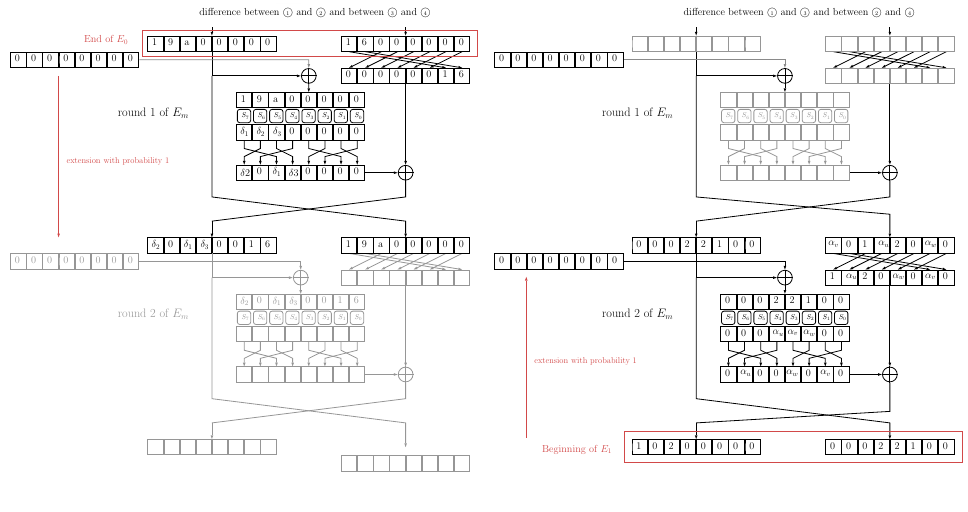
Figure 12: Concrete 2-round boomerang switch on LBlock , derived from